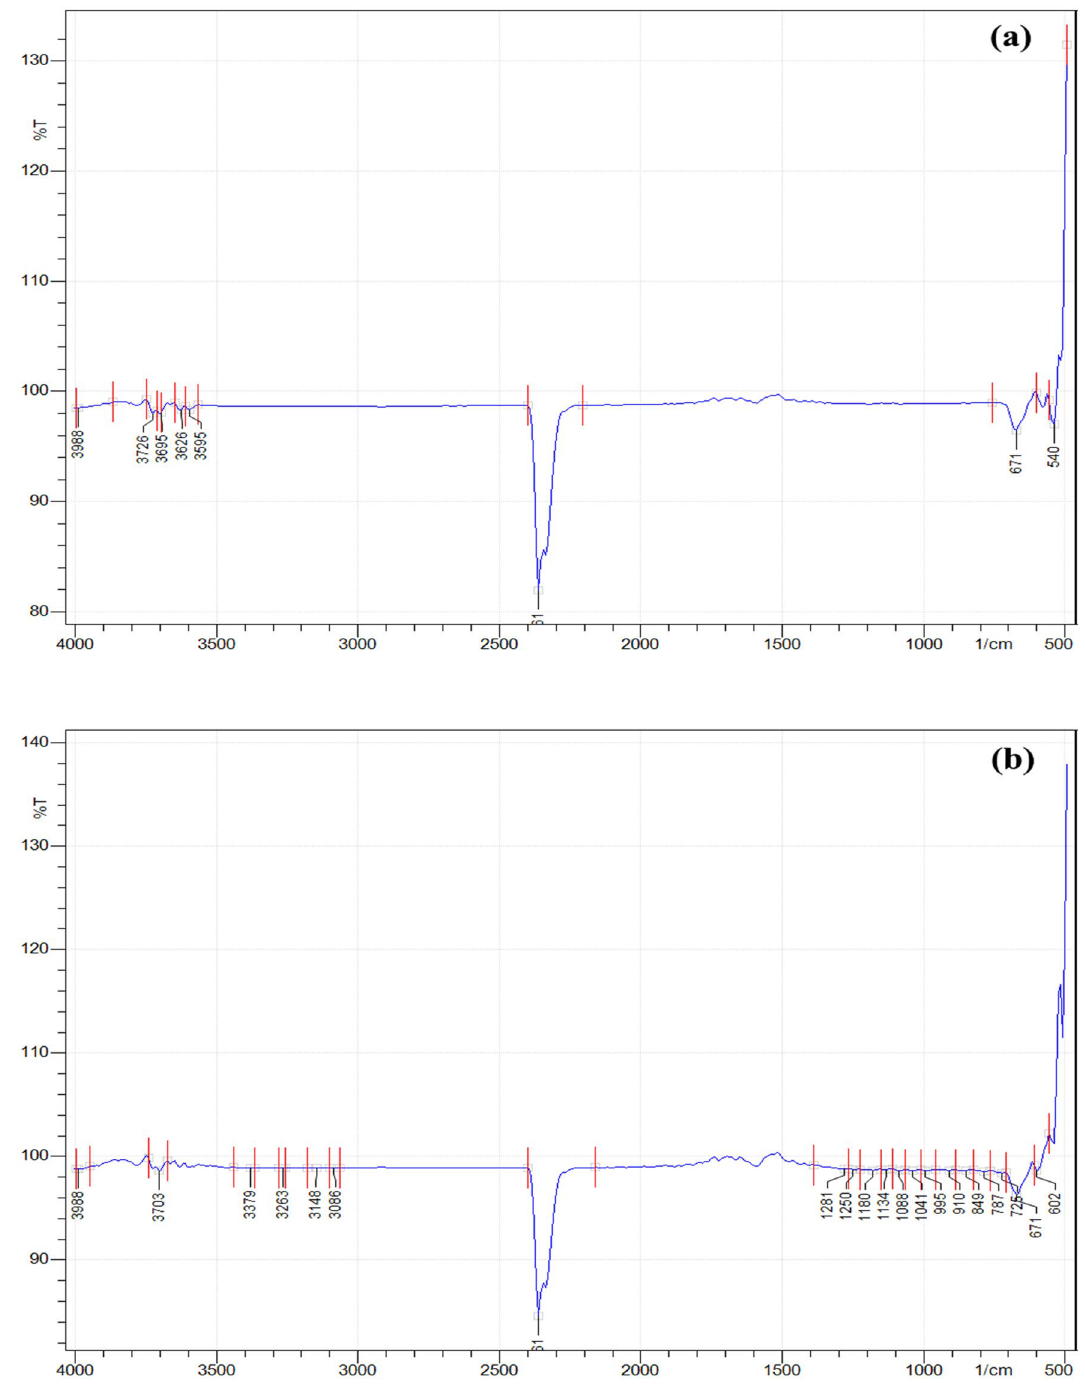
Figure 2. FT-IR representation of IR signals at spectra of ( a ) UPKC surface and ( b ) CPKC